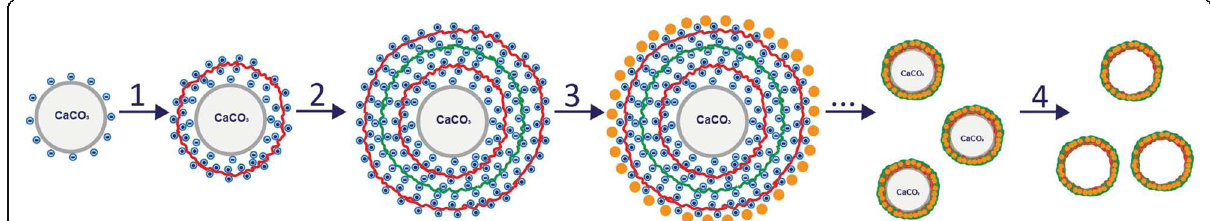
Fig. 3 Preparation procedure for microcapsules encoded with quantum dots: formation of the layers of the polycation (1) and polyanion (2), the PAH and PSS polyelectrolytes, respectively, on the matrice surface; encoding of the resultant microparticles with quantum dots and further layer-by-layer polymers deposition (3); removal of the calcium carbonate core (4)